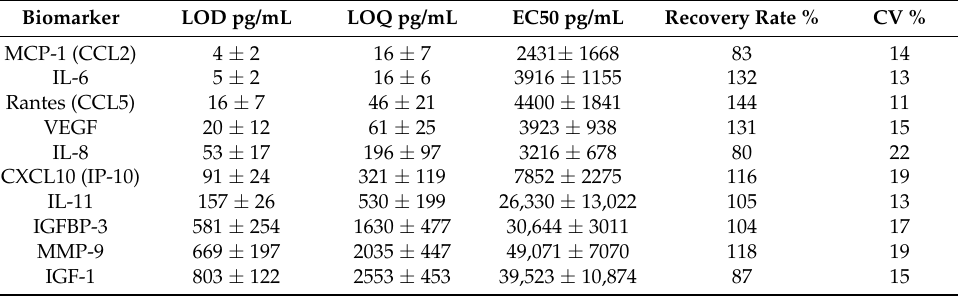
Table 1. Limit of detection (LOD), limit of quantification (LOQ), half maximal effective concentration (EC50), recovery rates, and coefficient of variation (CV) of sandwich assays for IL-6, IL-8, IL-11, MCP-1, CXCL10, Rantes, IGF-1, VEGF, MMP-9, and IGFBP-3 on the multiplexed chip platform in Dulbecco’s Modified Eagle Medium/Nutrient Mixture F-12 DMEM/F-12 cell culture medium supplemented with 10 mg/mL bovine serum albumin BSA. Data of LOD, LOQ, and EC50 are shown as means ± SEM of three experiments. The coefficient of variation is calculated as the mean of eleven standards of three experiments. The recovery rate is given for a spiked concentration within the linear range of the